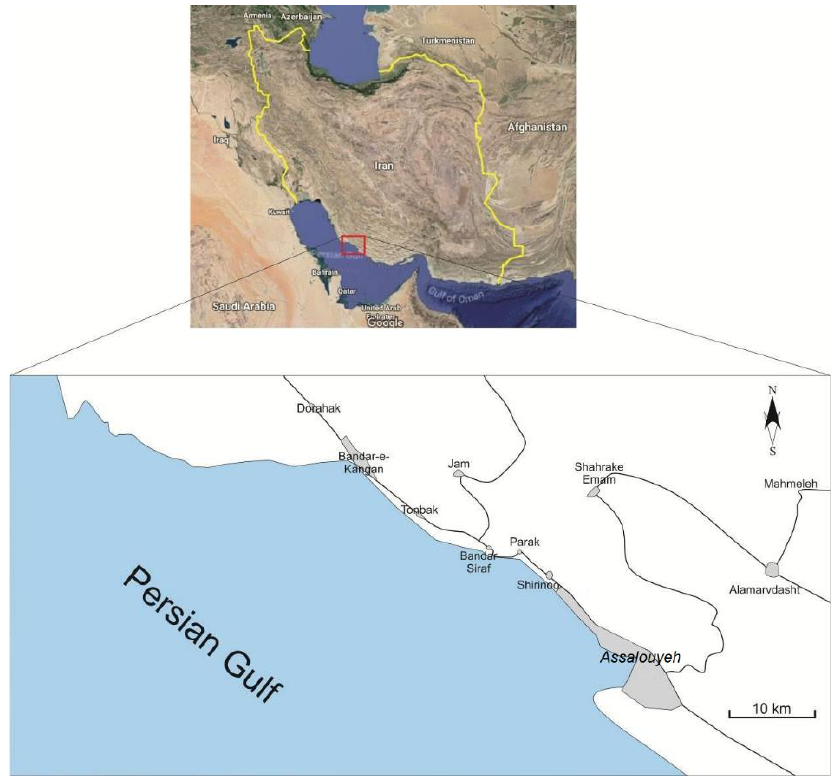
Figure 1. Location map of the South Pars region in Iran.